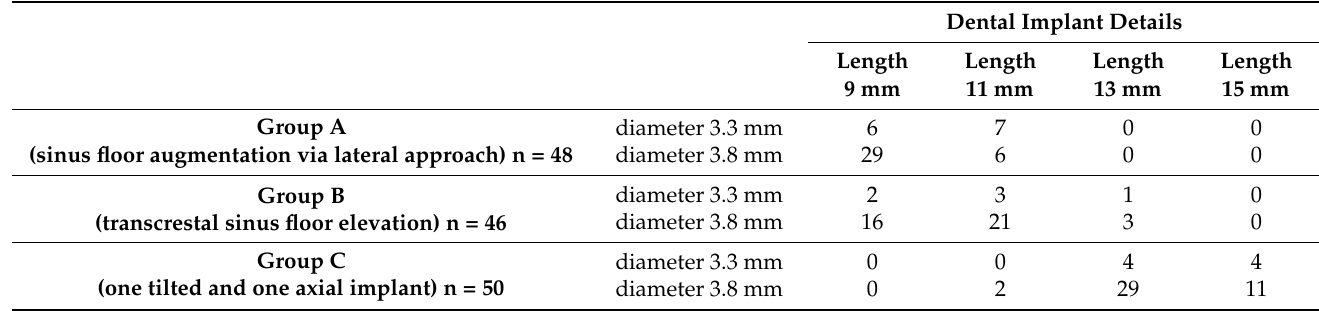
Table 2. Number, diameter, and length of dental implants classified by group.